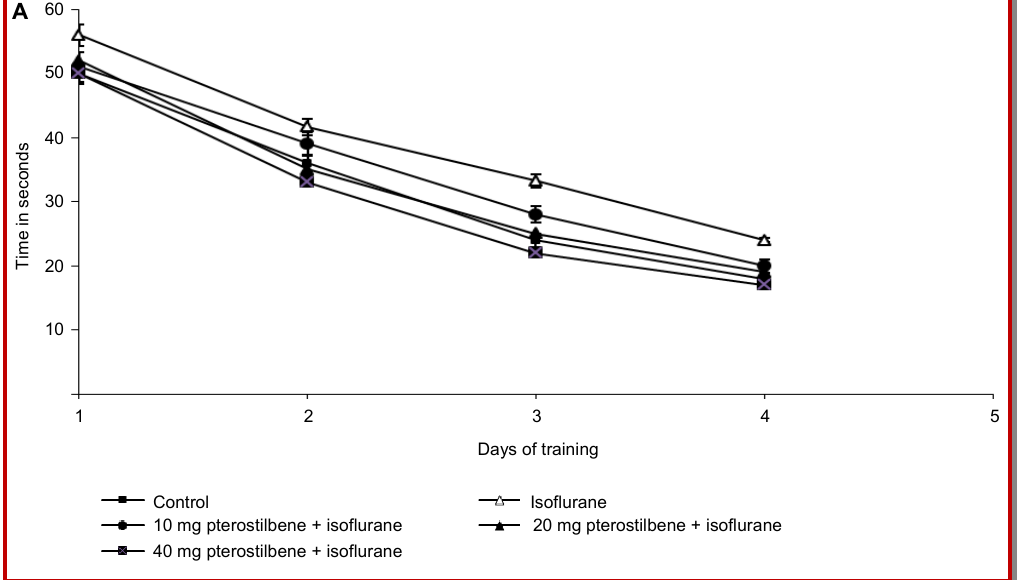
Figure 3A: Morris water maze test - effects of isoflurane and pterostilbene on memory and learning ability Values are represented as mean ± SD;